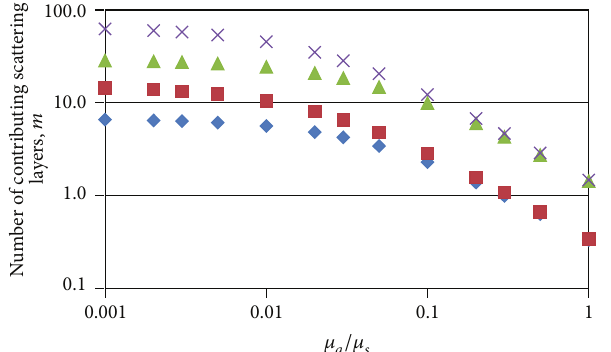
Figure 5: Number of contributing 𝑚 -terms (scattering layers or transport depths) as a function of 𝜇 𝑎 /𝜇 𝑠 ratio for different 𝛼 and 𝑔 . 𝛼 = 0.5 , 𝑔 = 0.8 (rhomboids), 𝛼 = 0.5 , 𝑔 = 0.9 (squares), 𝛼 = 0.05 , 𝑔 = 0.8 (triangles), 𝛼 = 0.05 , and 𝑔 = 0.9